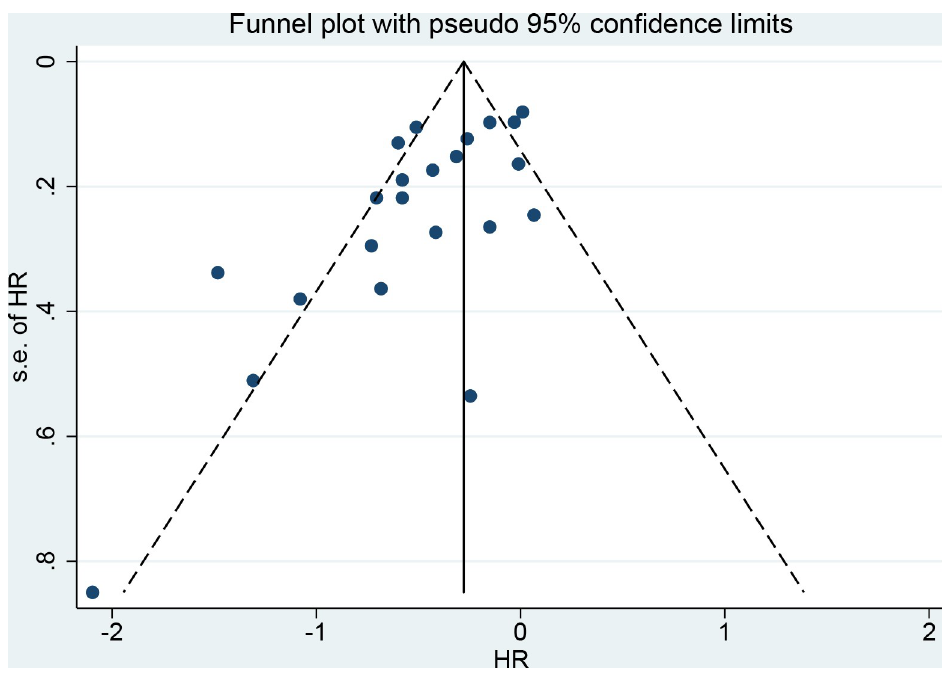
Fig 8. Funnel plot of overall survival in the included